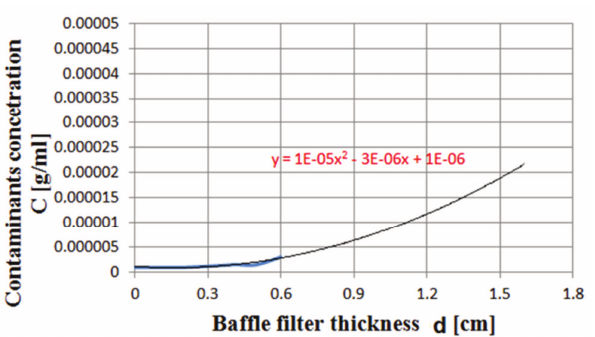
Fig. 2. Course of characteristic in the first stage of contaminants develop- ment together with the trend line and the development forecast after application of the countering microorganisms Besides, for each stage of the filtration process trendline and the equation that describes it has been designated.